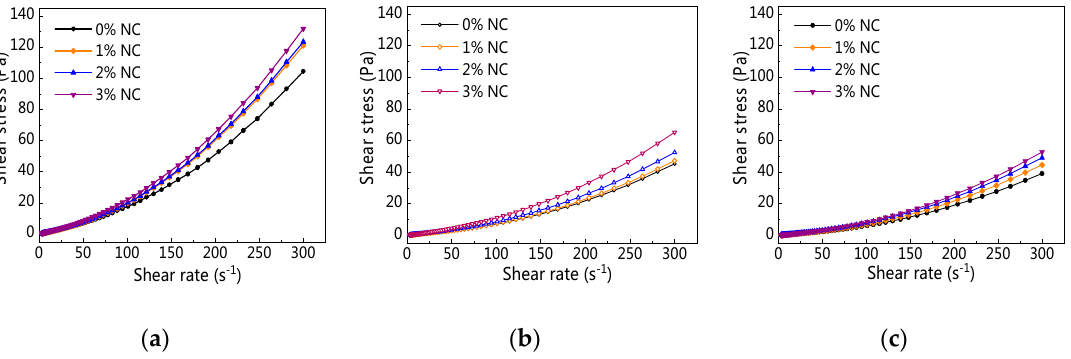
Figure 14. Rheological curve of C–FA paste with nano-CaCO 3 (NC) under different resting time: ( a ) 5 min; ( b ) 60 min; ( c ) 120 min.